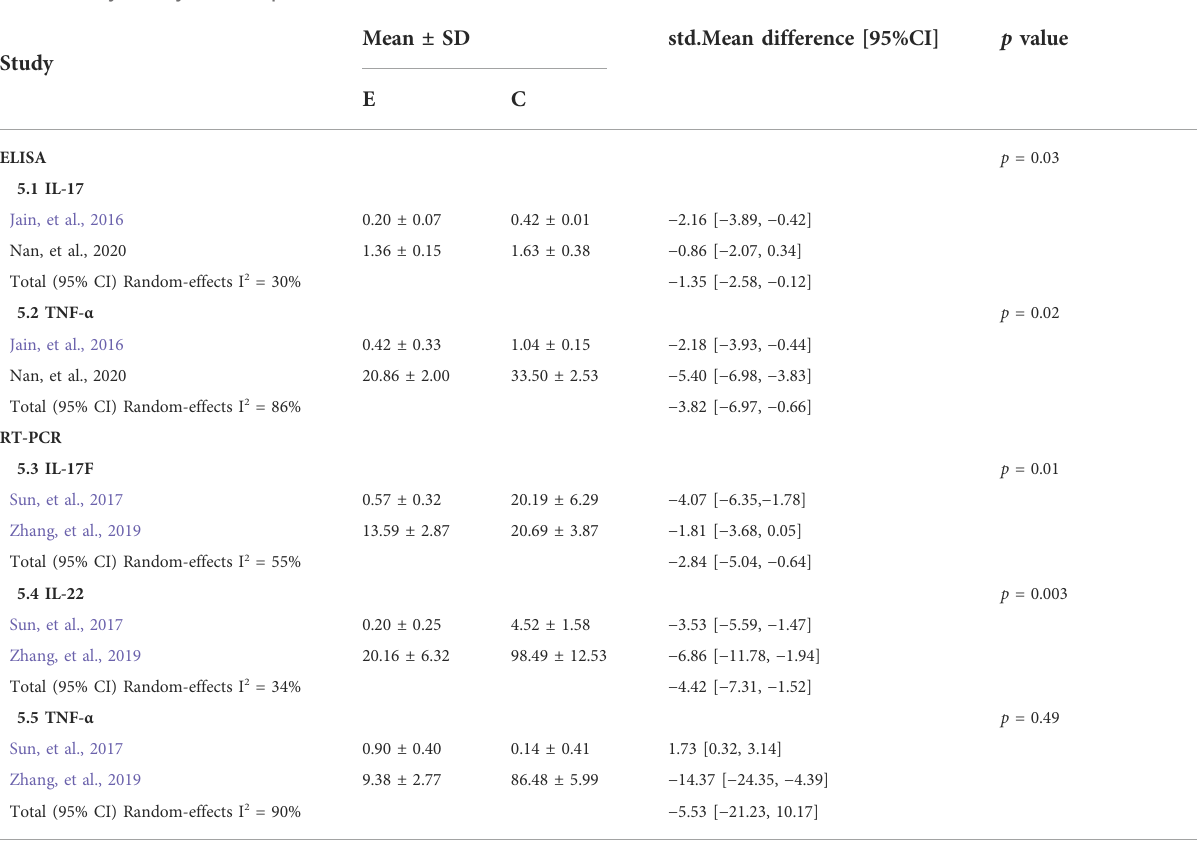
TABLE 5 Analysis of cytokines in preclinical studies in vivo.